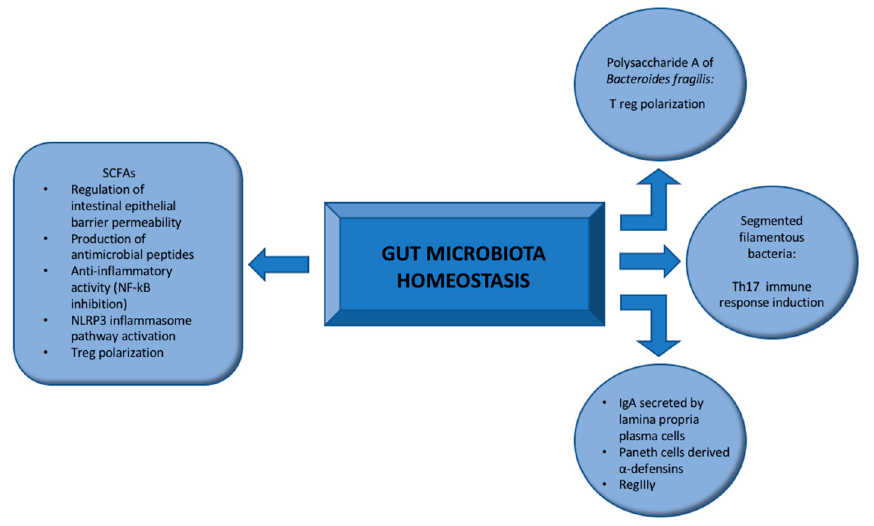
Figure 1. Regulation of gut microbiota homeostasis: The maintenance of intestinal microbiota homeostasis is mainly promoted by SCFAs (butyrate, propionate, and acetate), which regulate intestinal barrier permeability by orchestrating tight junction assembly and producing antimicrobial peptides. SCFAs exert immunomodulatory functions through the regulation of the innate immune response and the polarization of T cells towards a T reg phenotype. Other factors promoting intestinal homeostasis include molecules such as polysaccharide A of the commensal Bacteroides fragilis , IgA secreted by lamina propria plasma cells, Paneth cells derived α -defensins, and the antibacterial lectin RegIII γ expressed in epithelial cells. Segmented filamentous bacteria tightly adhere to intestinal epithelial cells in the ileum inducing Th17-mediated immune response. NLRP3: NOD-, LRR-, and pyrin domain-containing protein 3; NF- κ B: nuclear factor kappa B; SCFAs: short-chain fatty acids; Th17: T helper 17; T reg: T regulatory.